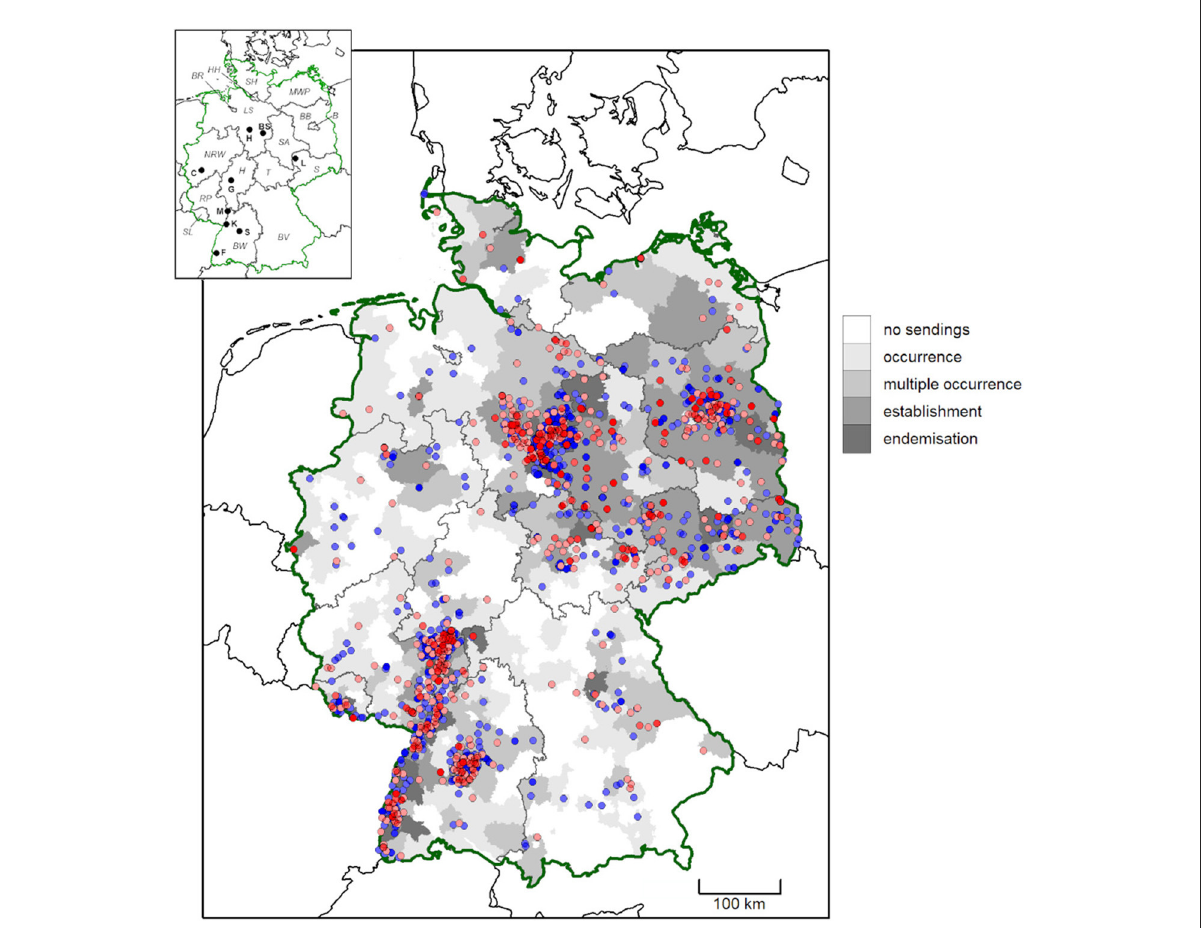
FIGURE1 Geographic origin of D. reticulatus submissions from German citizens between February 2019 and May 2021. Districts are shaded according to evidence for tick occurrence (single tick/location), multiple occurrence (2–5 ticks/location), establishment ( > 5 ticks/location) and endemisation ( > 5 ticks/location, from multiple years). High and medium accuracy records are depicted as dots. Locations previously published by Drehmann et al. (10) are shown in blue, while new records are shown in red. More intense colors indicate multiple findings in close proximity. In the map insert, federal states are abbreviated with italic letters (B, Berlin; BR, Bremen; BW, Baden-Wuerttemberg; BV, Bavaria; BB, Brandenburg; HH, Free and Hanseatic city of Hamburg; H, Hesse; LS, Lower Saxony; MWP, Mecklenburg-Western Pomerania; NRW, North Rhine-Westphalia; RP, Rhineland-Palatinate; S, Saxony; SA, Saxony-Anhalt; SH, Schleswig-Holstein; SL, Saarland; T, Thuringia) and cities with bold letters (BS, Brunswick; C, Cologne; F, Freiburg; G, Gießen; H, Hanover; K, Karlsruhe; L, Leipzig; M, Mannheim; S,